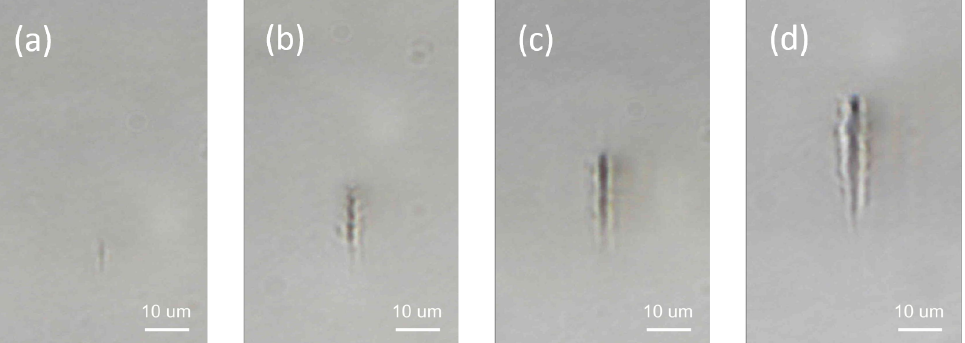
Figure 2. Damage created inside borosilicate glass using single shot of picosecond laser pulse. The focal position is about 100 µm underneath the front surface of the borosilicate glass plate. The laser beam is propagating from top to bottom. The pulse energy is chosen to produce from just visible laser damage to obvious damage tracks inside the glass plate. For the cases shown here, the pulse energy are ( a ) 1 µJ, ( b ) 2 µJ, ( c ) 3 µJ, ( d ) 5